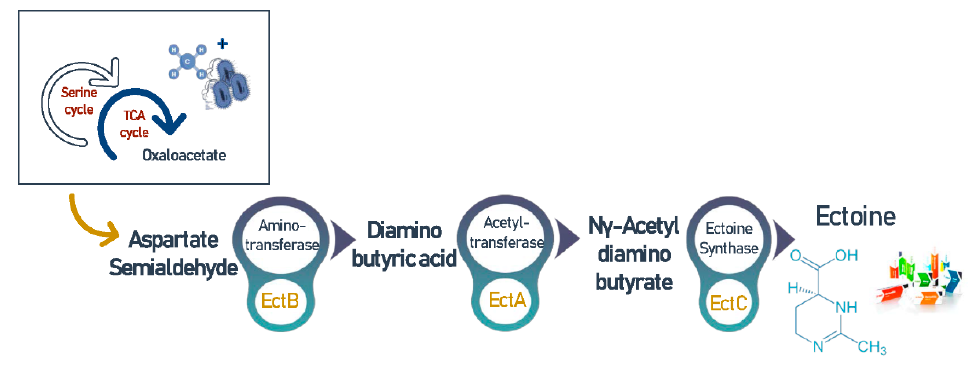
Figure 5. The cascade of reactions involved in the biochemical synthesis of ectoine.